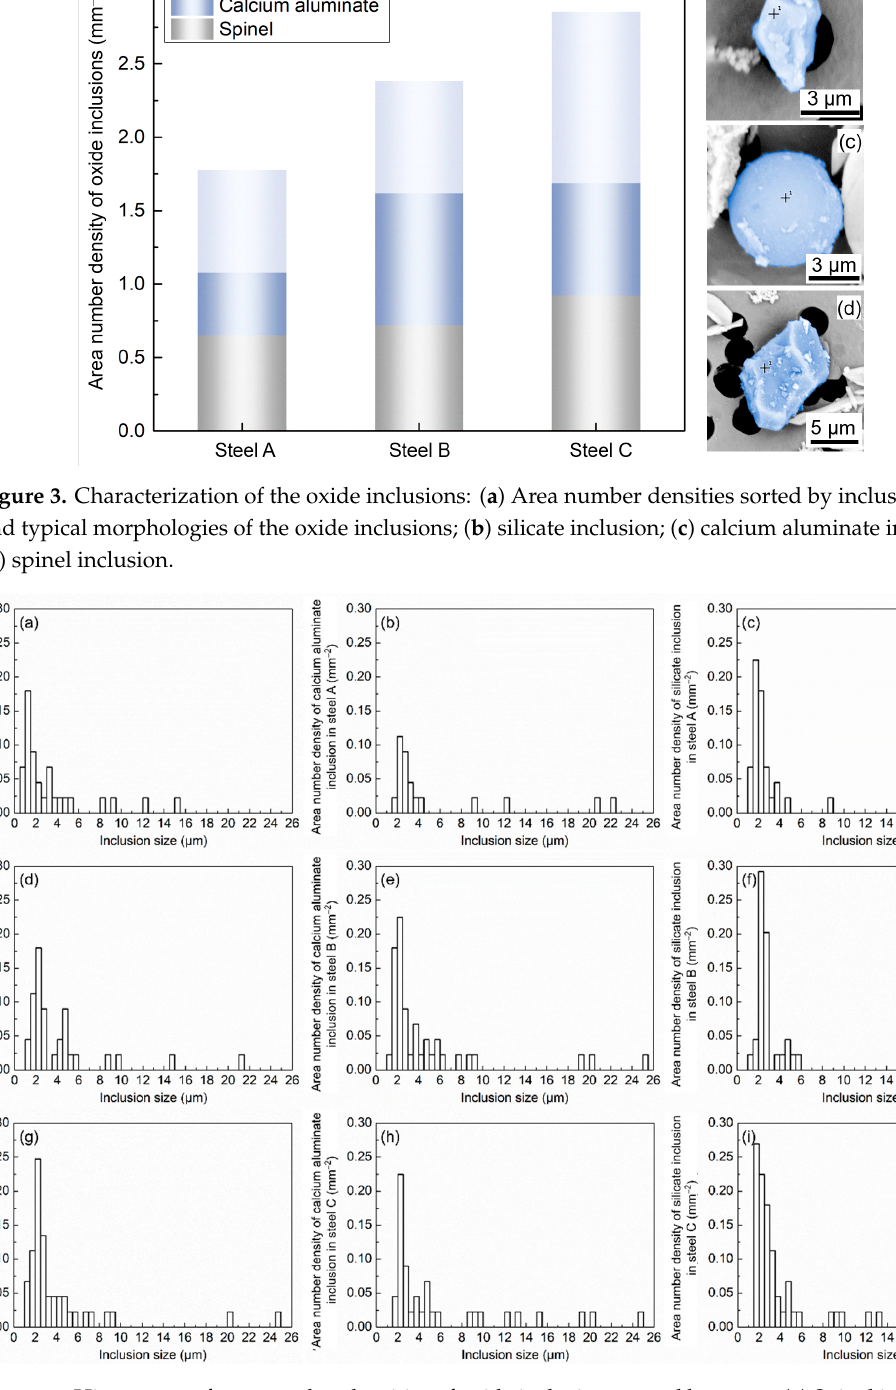
Figure 4. Histograms of area number densities of oxide inclusions sorted by types: ( a ) Spinel inclusions in steel A; ( b ) calcium aluminate inclusions in steel A; ( c ) silicate inclusions in steel A; ( d ) spinel inclusions in steel B; ( e ) calcium aluminate inclusions in steel B; ( f ) silicate inclusions in steel B; ( g ) spinel inclusions in steel C; ( h ) calcium aluminate inclusions in steel C; ( i ) silicate inclusions in steel